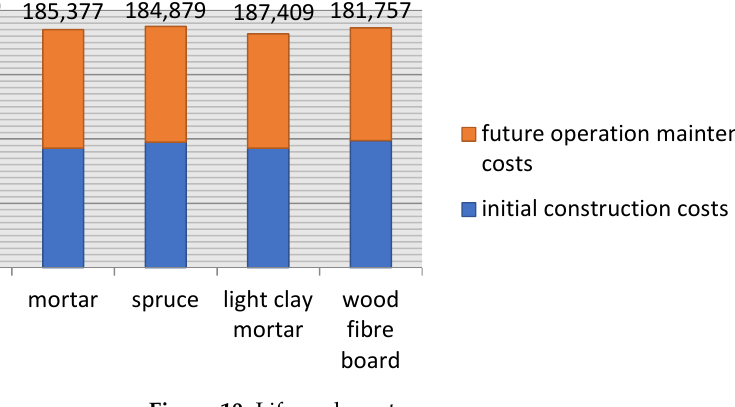
Figure 10. Life-cycle cost.